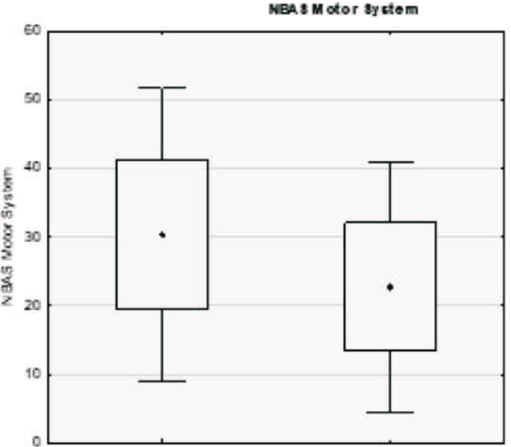
Figure 4. Neonatal Behavioral Assessment Scale (Motor System) vs. General Movements